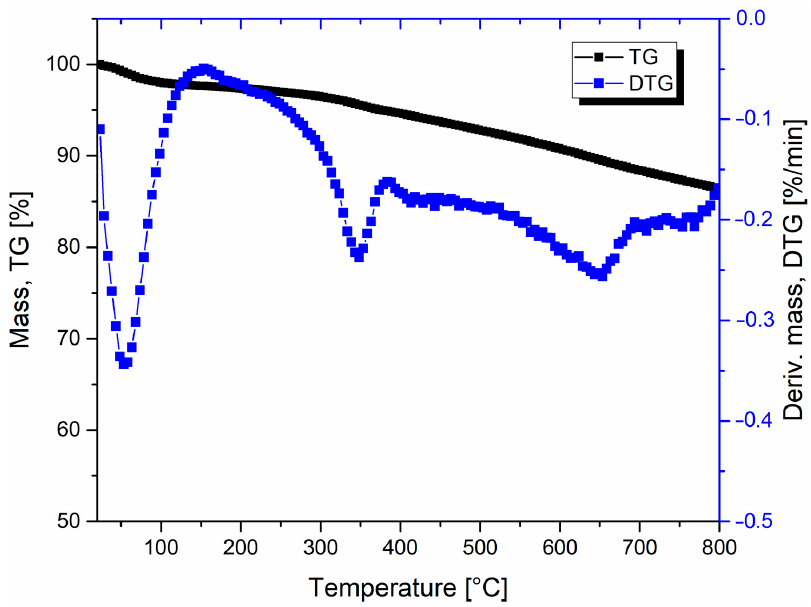
Figure 2. The results of the thermogravimetric analysis for pure BioC filler. Mass loss (TG) and derivative mass (DTG) plots are combined on one chart. Table 1. Formulations of polyurethane